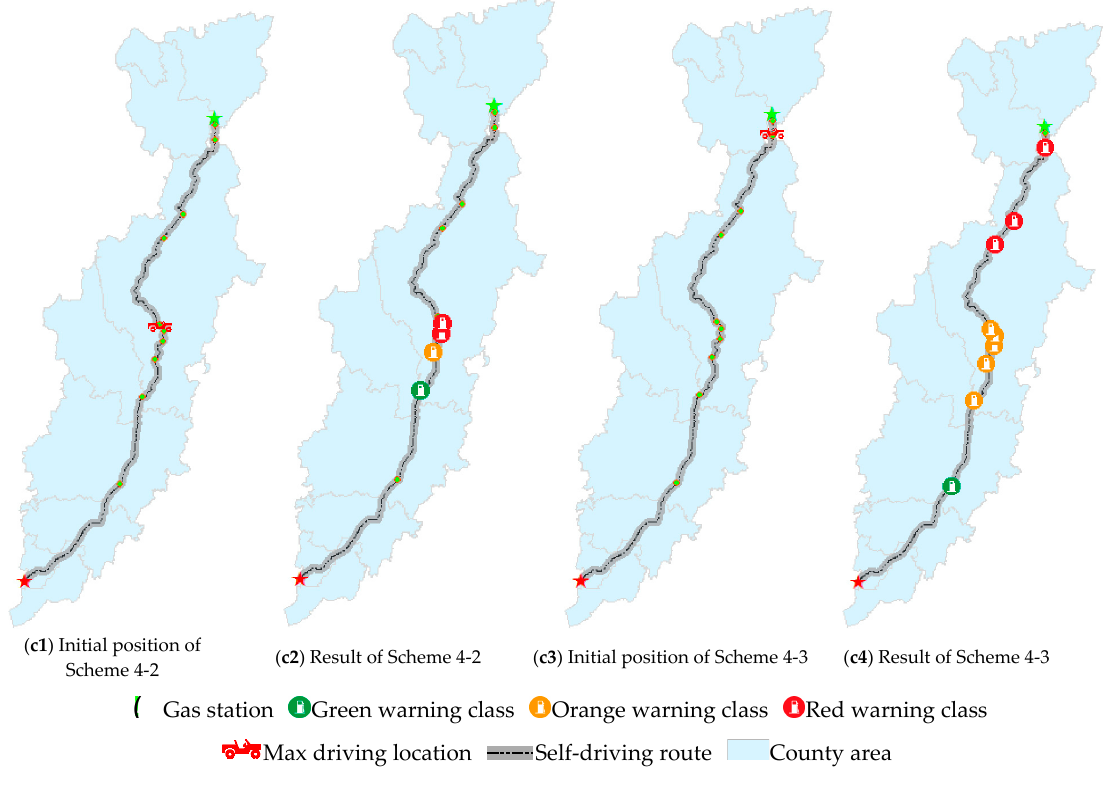
Figure 8. Results and processing of scenario simulations.